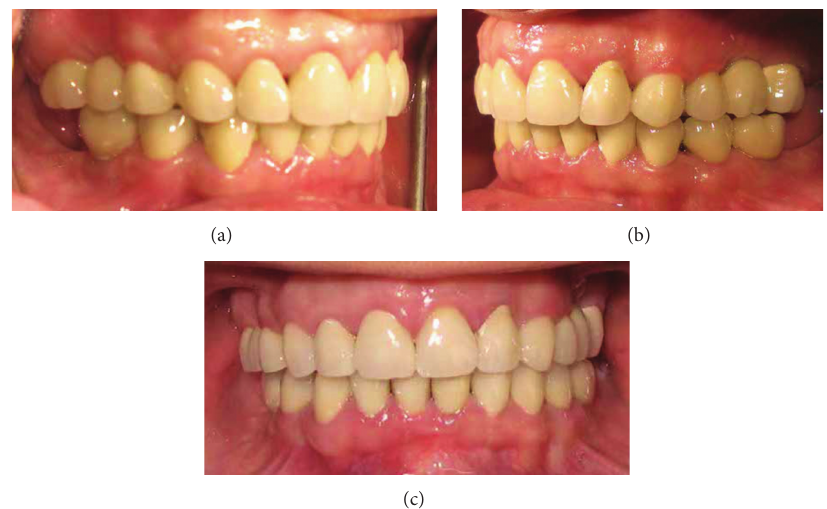
Figure 4: Views of MCRs in the mouth.